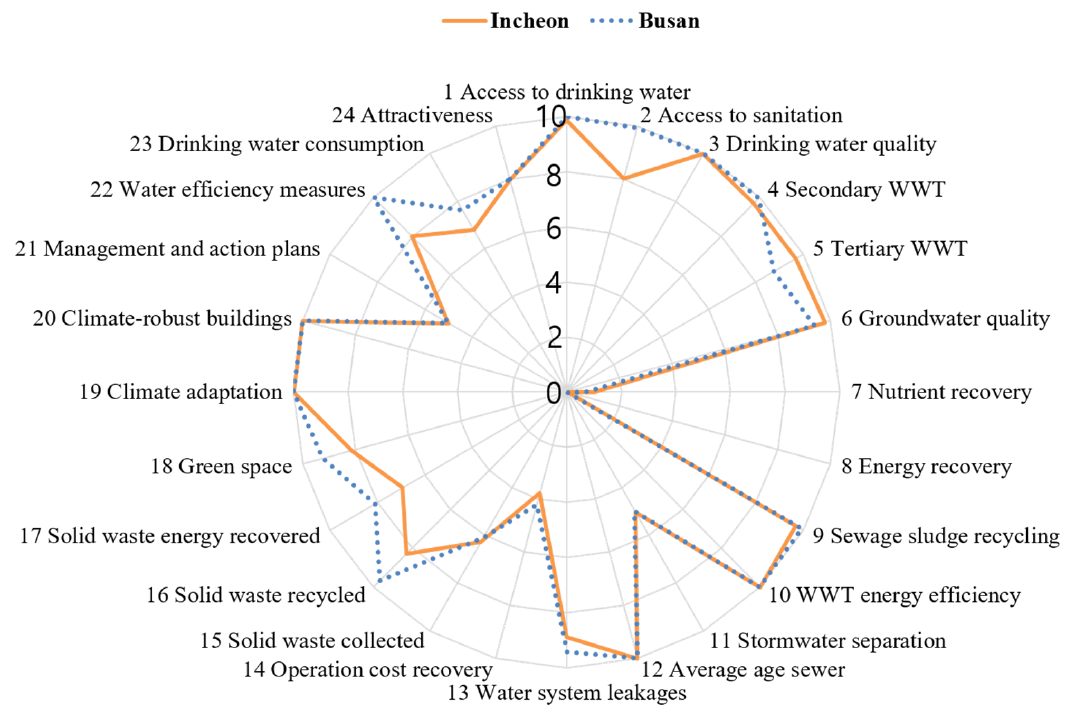
Figure 5. The result of CBF of Incheon (orange) and Busan (blue dot).